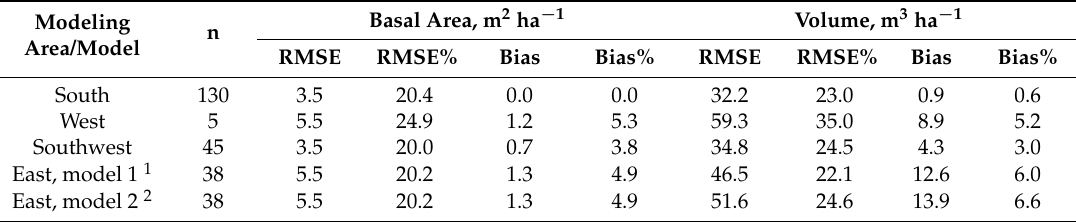
Table 6. Summary of plot-level validation results in the deciduous forest class. RMSE = root mean square error, RMSE% = error relative to mean value of plots, n = number of plots used in validation.